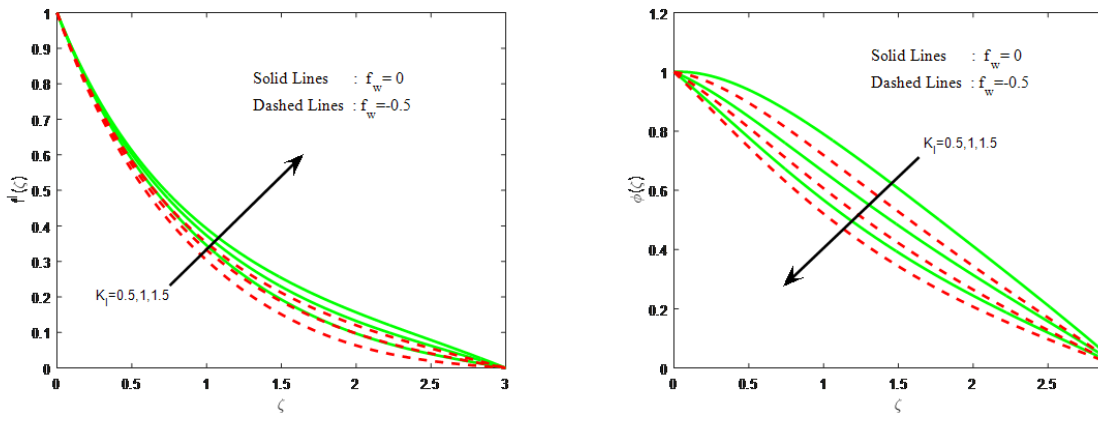
Fig. 13: The effect of chemical reaction parameter ( K l ) on velocity field